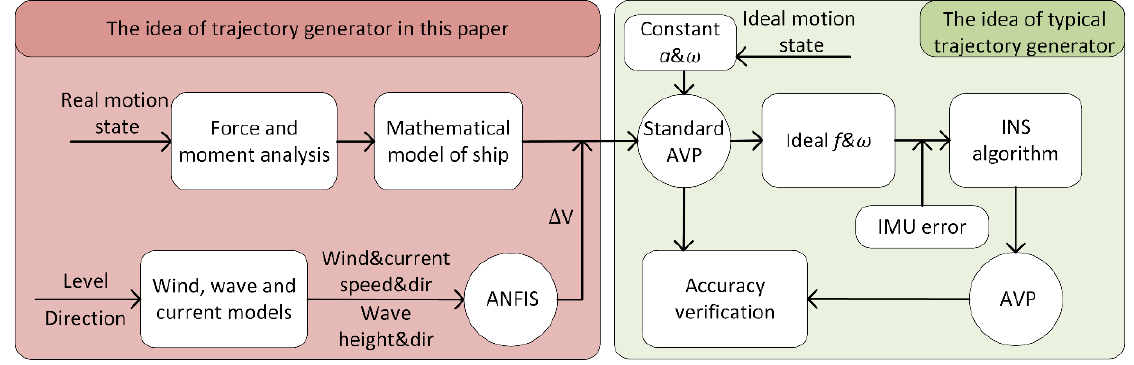
Figure 1. Flow chart of design and simulation of ship trajectory generator.